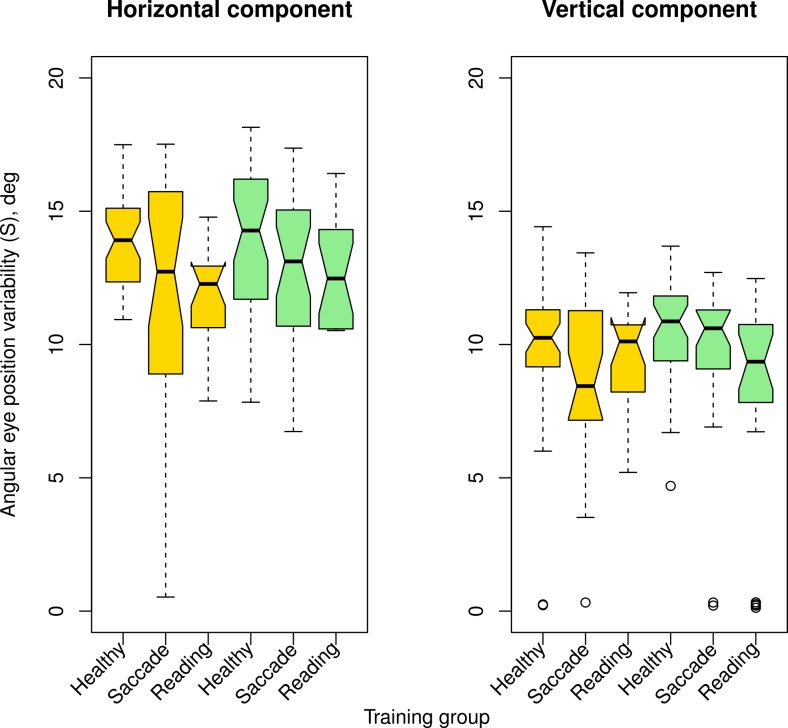
Box plots of horizontal eye position variability in degrees.The horizontal component is plotted on the left, the vertical component is shown on the right. Different training groups are plotted on the abscissa for the pre-training (gold symbols) and post-training (green symbols) conditions. Boxes represent the median and the 25th to 75th percentile of the distributions; whiskers represent 1.5* IQR excluding outliers. This shows that the range of horizontal eye movements amplitudes was significantly larger than that of the vertical eye movements.